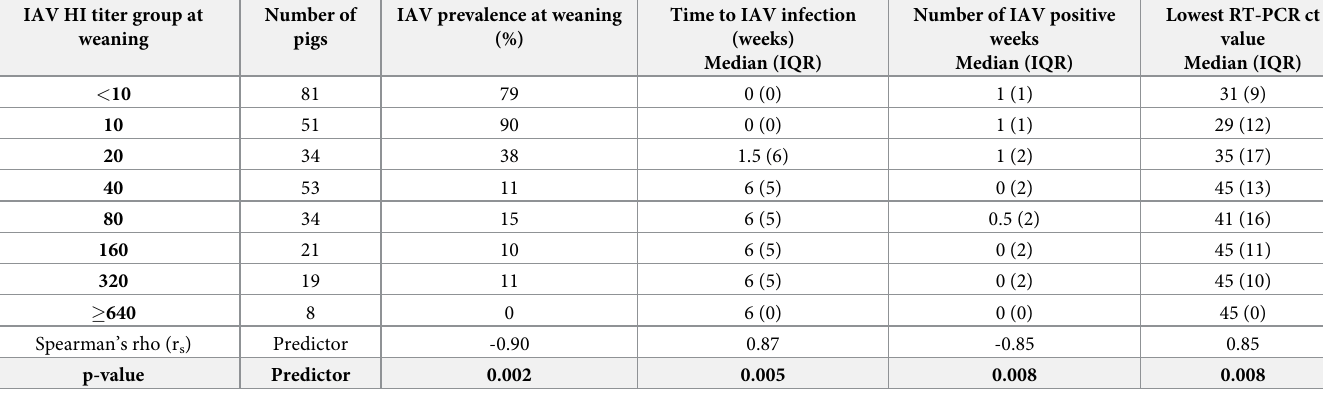
Table 3. Correlation of influenza A virus (IAV) hemagglutination inhibition (HI) titer group at weaning with infection parameters in nursery pigs. IAV HI titer group at Number of weaning